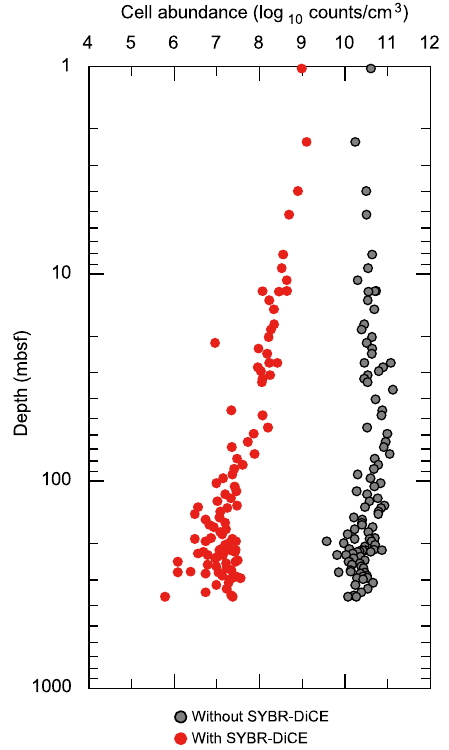
Fig. 2 Cell abundance plot for the samples obtained from offshore Shimokita Peninsula. Increased deviation of observed cell abundance was found between counts conducted without (gray) and with (red) SYBR-DiCE method along the depth of subseafloor sediments. Modified from Morono et al.